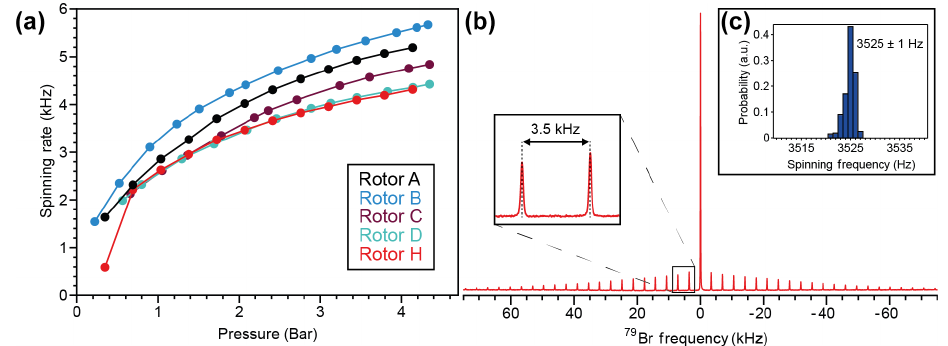
Figure 3. Spin test data. (a) Spinning rate as a function of applied air pressure for rotors A, B, C, D, and H. (b) 79 Br spectrum of KBr packed into rotor H and spinning at 3.5kHz at the magic angle; 512 scans. (c) Histogram of spinning frequencies without spinning regulation over the 10min KBr data acquisition